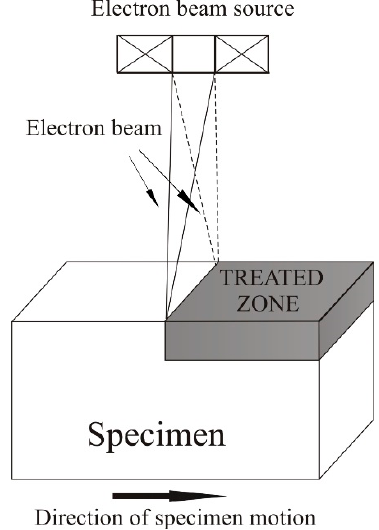
Figure 1. Sketch of the electron beam treatment experiment.